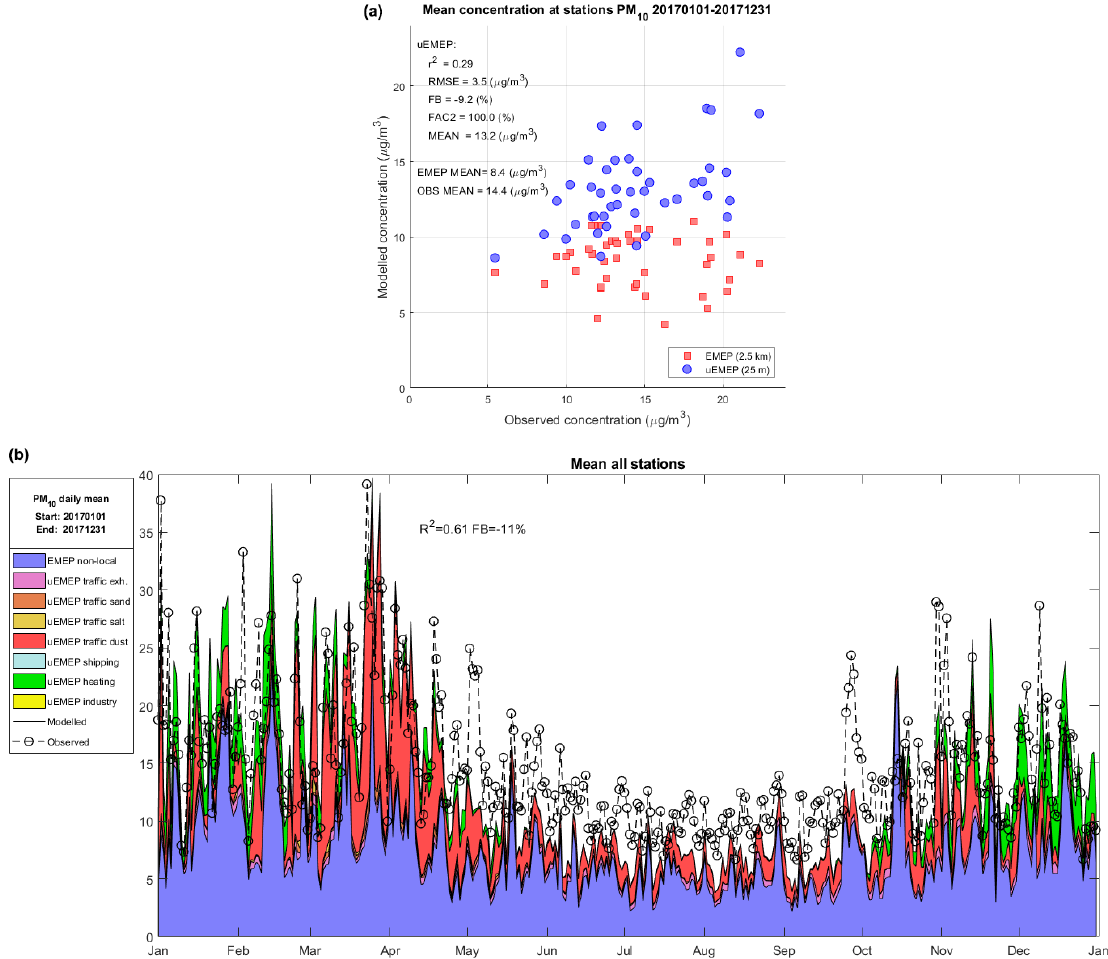
Figure 10. (a) Scatter plot comparison of modelled and observed PM 10 for annual average concentrations at each station. Shown are the results for both uEMEP and EMEP. Comparative statistics are shown for the uEMEP calculation. EMEP and observed means are also included. (b) Source contributions from both uEMEP and EMEP models are shown for the temporal modelling results along with the EMEP 2.5km calculation (EMEP4NO). A total of 45 stations are used in the